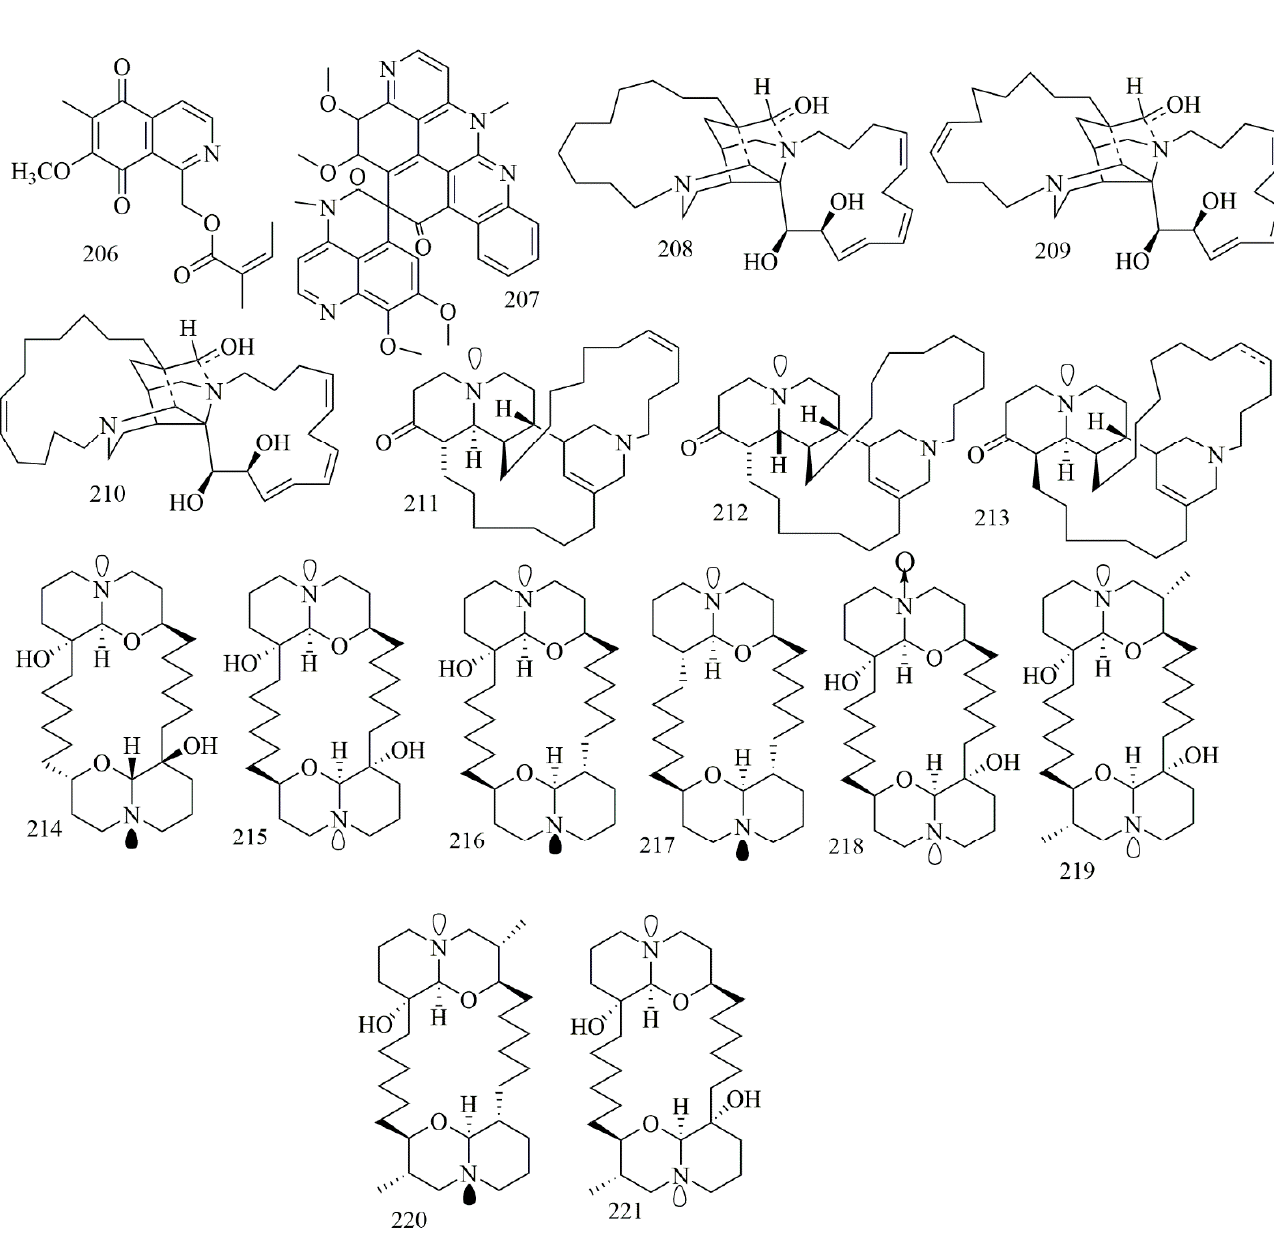
Figure 15. Quinoline and quinolizidine alkaloid structures in sponges. Table 15. Cytotoxic activity of quinoline and quinolizidine alkaloids.